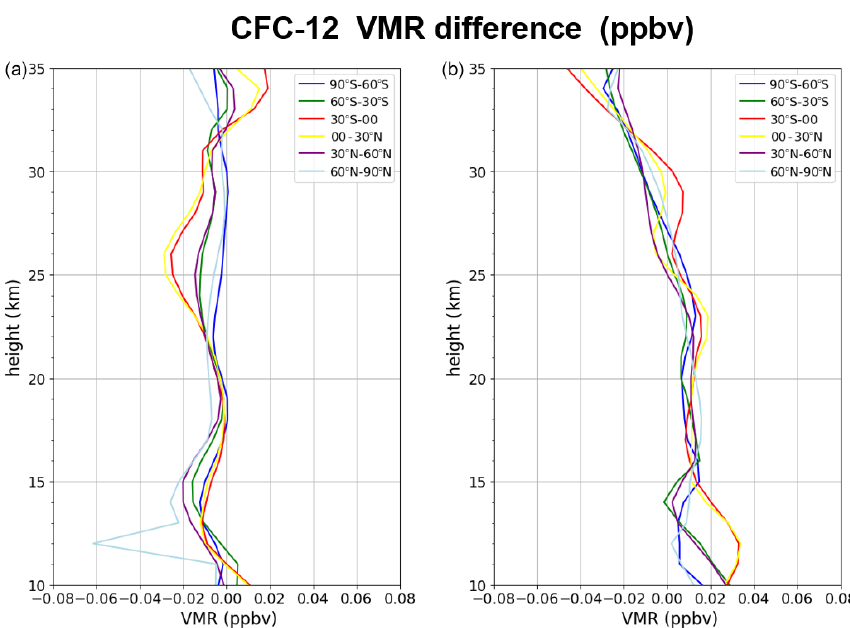
Figure 16. Absolute difference between MIPAS V8 and MIPAS V6 CFC-12 profiles at different latitude bands for selected orbits in FR (a) and OR (b)